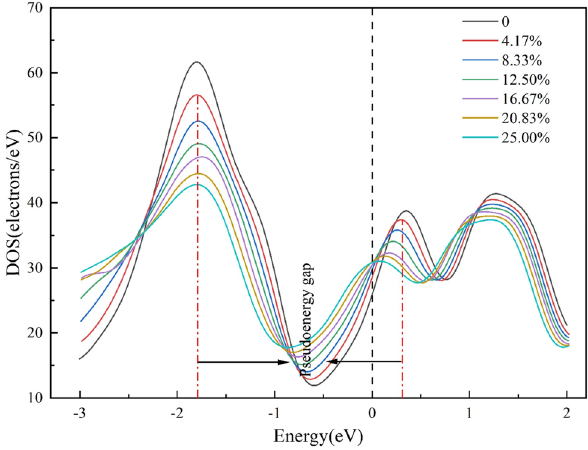
Figure 4: Total DOS of TaCr 2 alloys doped with di ff erent atomic percentages of Ru element in the energy level range of − 3 to 2